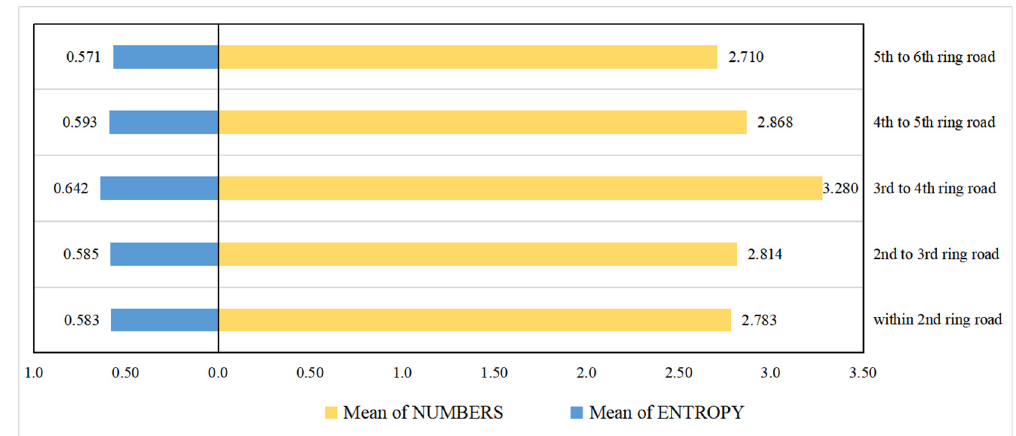
Figure 6. Spatial distribution of the entropy index ( A ) and type number index ( B ).